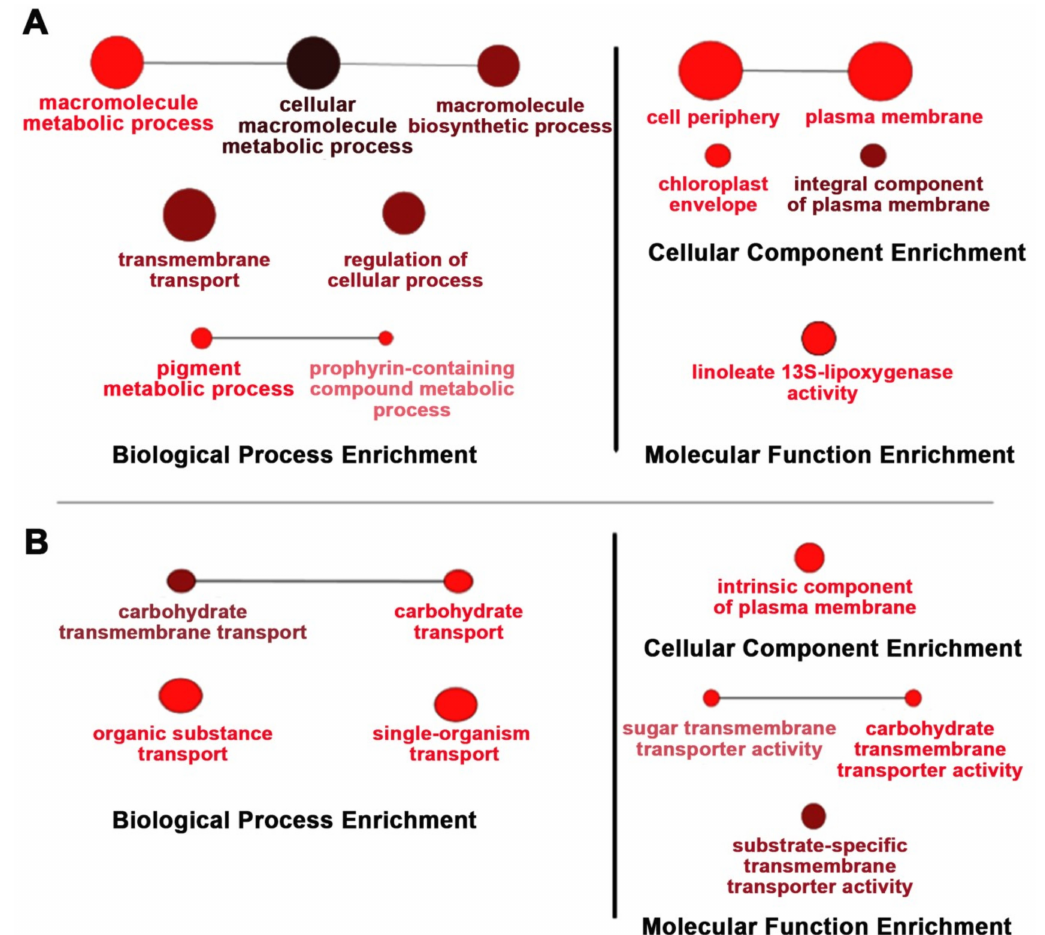
Figure 7. Gene enrichment analysis of the differentially expressed genes in the TOSL3 line, which overexpresses OsNUC1-S . The tissues for the transcriptome analysis were collected 3 days ( A ) and 9 days ( B ) after the first day of the booting stage. The darker colors represent the higher significance and the larger size of node represents the higher number of genes in the